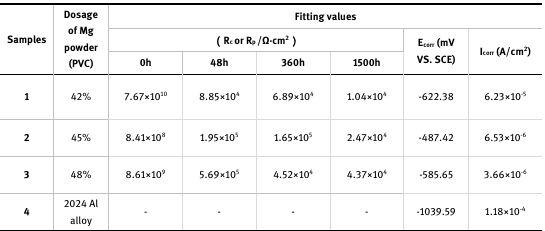
Table 2: Fitting values of EIS plots and Tafel polarization curve Dosage of Mg Samples